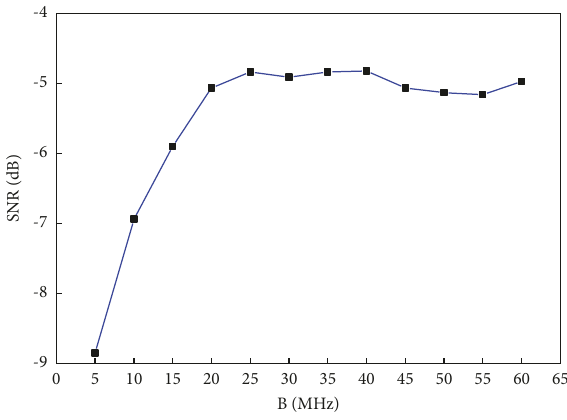
Figure 14: SNR under different signal